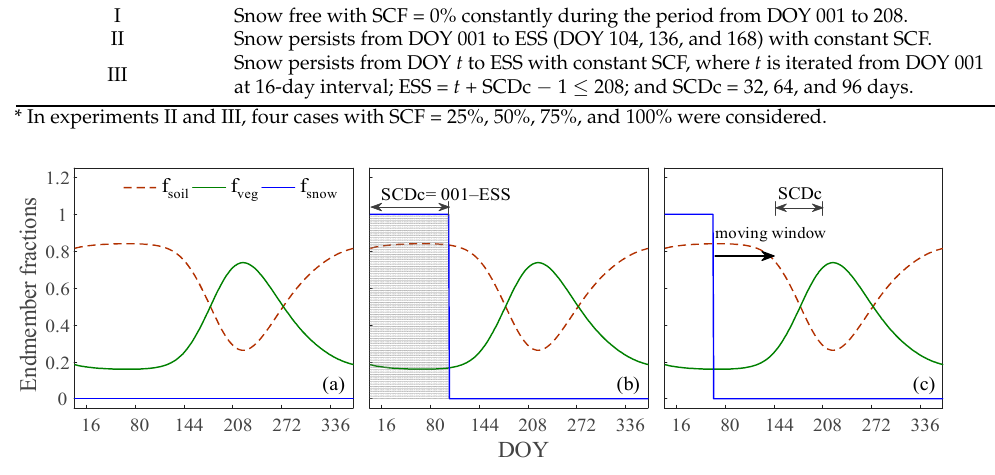
Figure 4. Temporal trajectories of coverage fractions of vegetation, snow, and soil for experiments I to III. ( a ) Experiment I with SCF = 0% constantly from DOY 001 to 208; ( b ) experiment II with snow persisting from DOY 001 to ESS with constant SCF; ( c ) experiment III with snow persisting from DOY t to ESS with constant